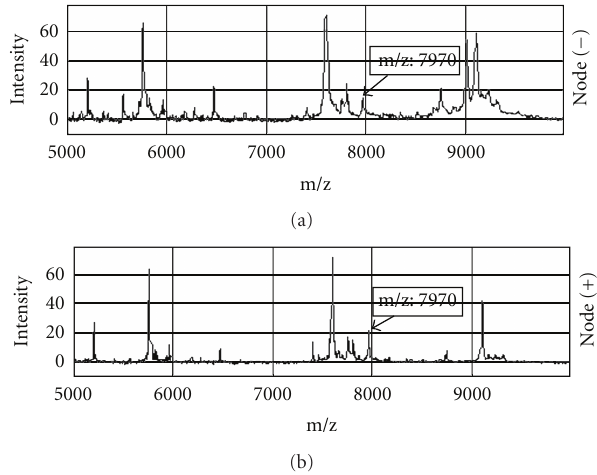
Figure 1: Representative serum protein profiling spectra of node- positive CRC patients and node-negative CRC patients. The peaks at m/z 7,970 were compared. m/z represents the mass to charge